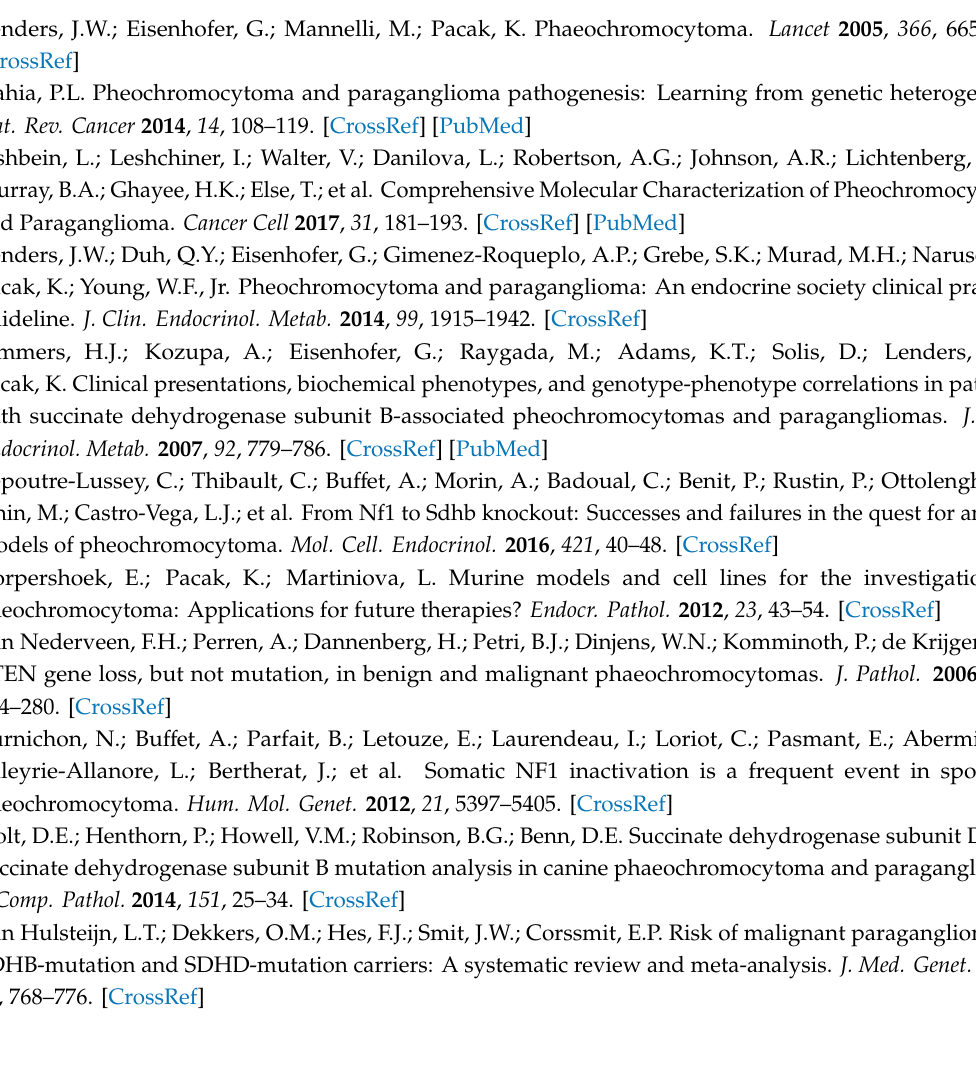
Figure S1: Summary of study design and results, Figure S2: Genomic locations SDH-related genes in the dog genome according to NCBI Genome Data viewer. Table S1: Clinical data, immunohistochemistry results and gene alterations in dog PPGL, Table S2: Primers, Table S3: Homology overview dog chromosome 5 and 26 with human